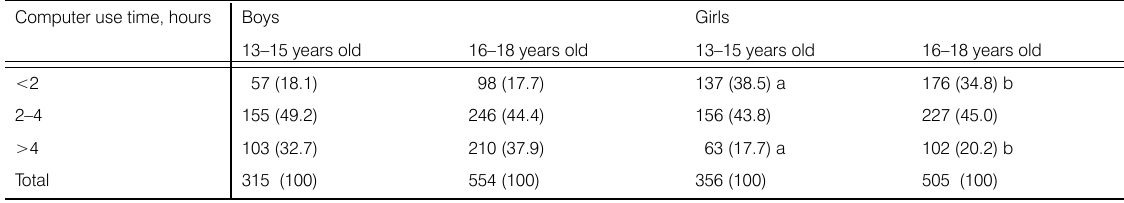
Number of cases (percent of total) a – p<0.001 compared with boys aged 13–15 years b – p<0.001 compared with boys aged 16–18 years